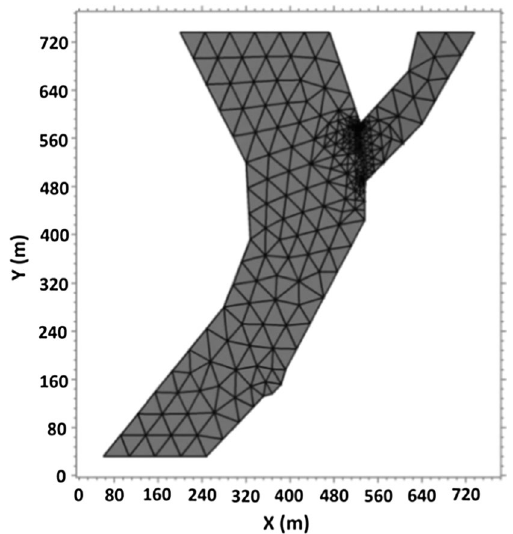
Fig. 2 Meshing and the geometry of the study